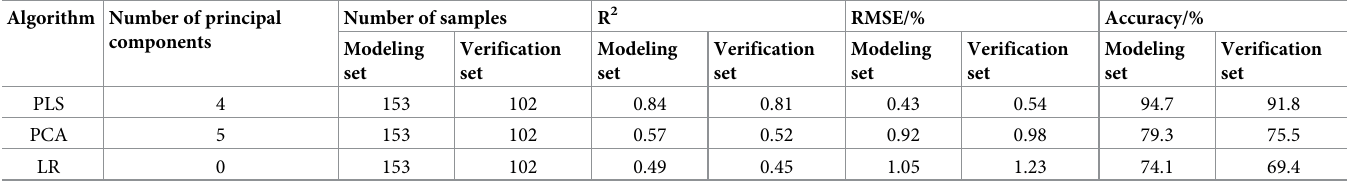
Table 4. Comparison of predicted abilities with PLS, LR and PCA.